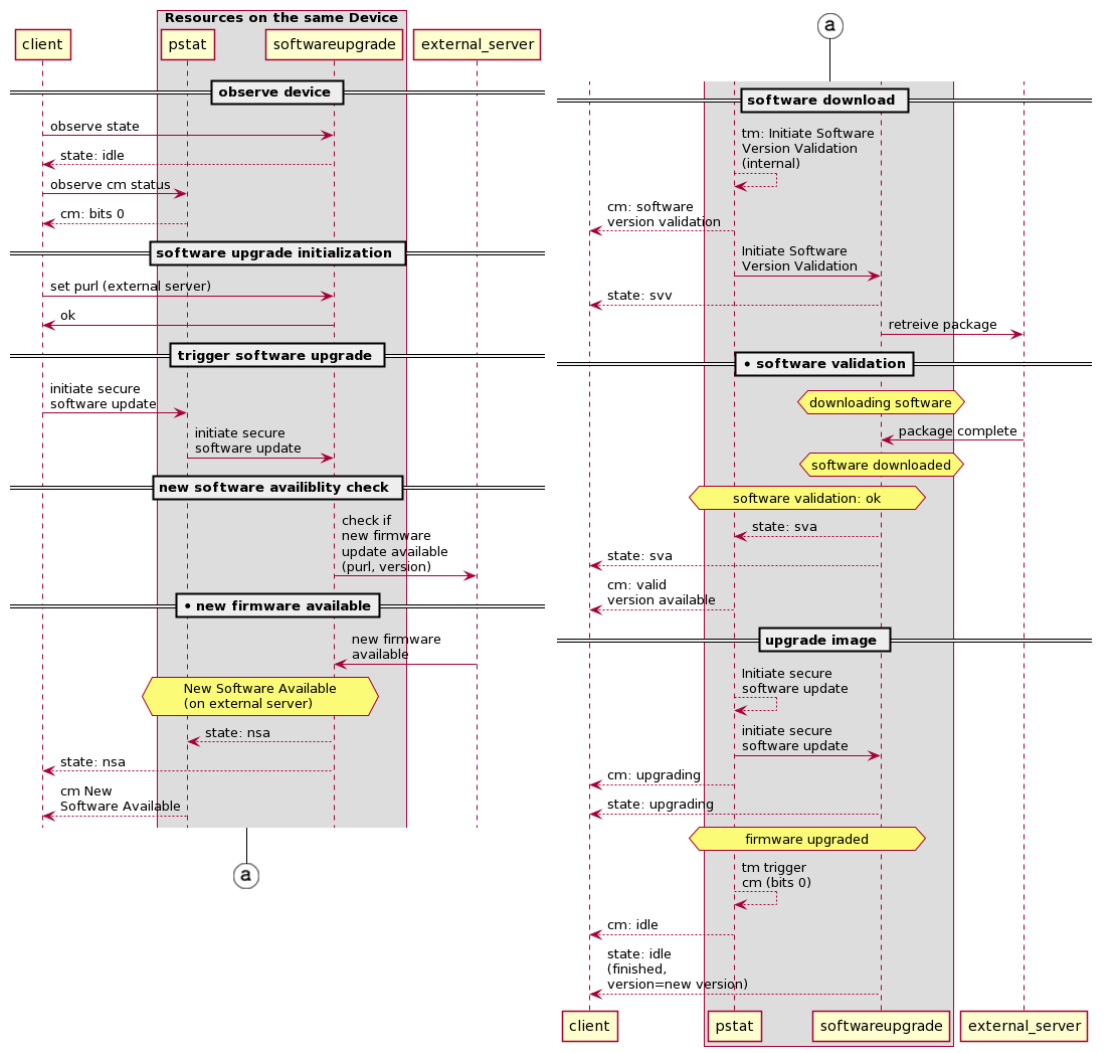
Figure 1. OCF firmware update protocol, adapted from [3] (from top-left to